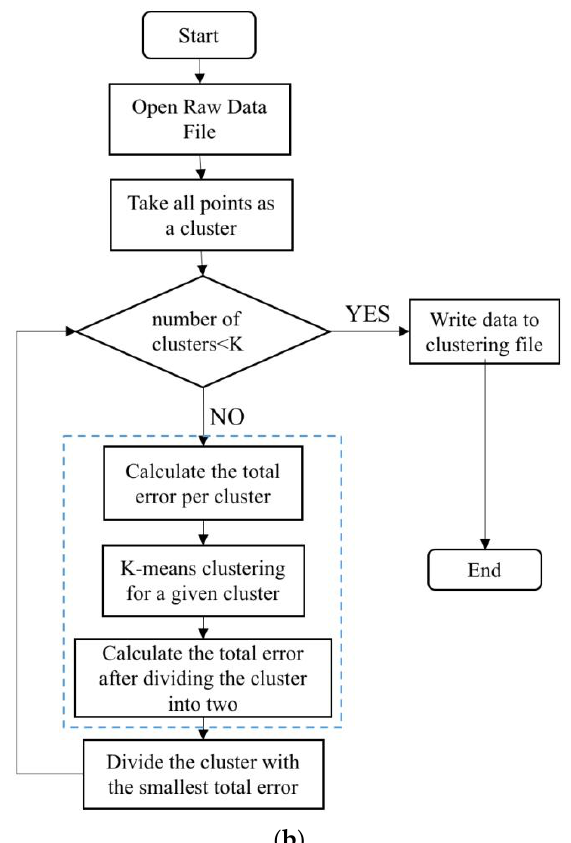
Figure 4. ( a ) The flow chart of k-means clustering analysis. ( b ) The flow chart of binary k-means clustering analysis.